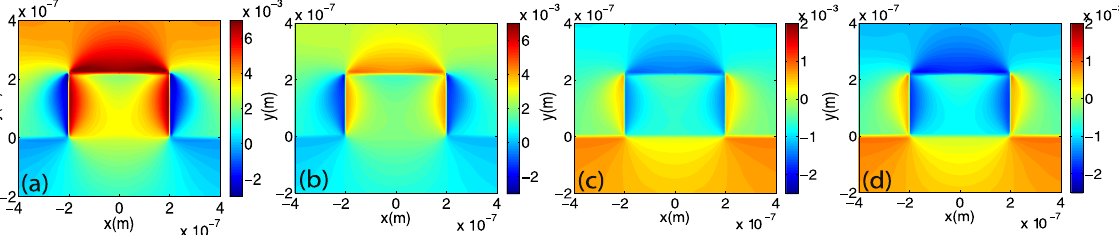
Figure 4. Effect of the annealing on the strain inside the structures. Simulated ε yy strain component for: the compressive stress sample ( a ) before and ( b ) after the annealing process, tensile stress sample ( c ) before and ( d ) after the annealing process. The annealing was performed at 500 °C during 30 minutes in atmospheric environment.